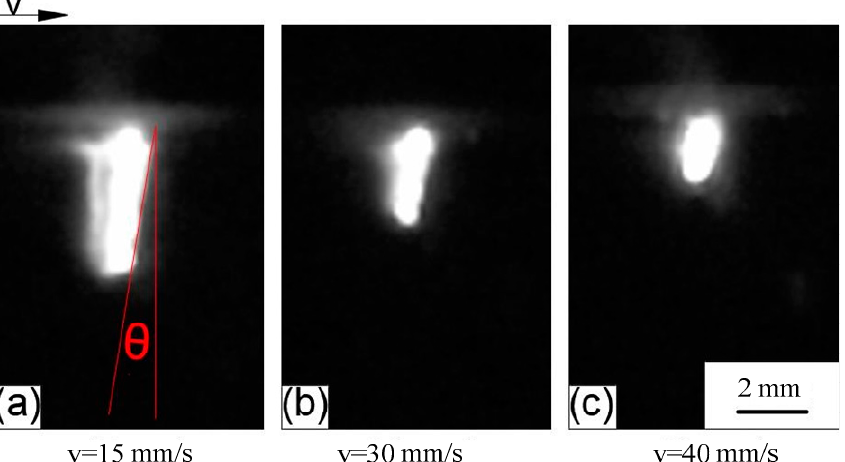
Figure 13. Keyhole shape at different speeds observed by the sandwich method: ( a ) Keyhole shape at welding speed of 15 mm/s; ( b ) Keyhole shape at welding speed of 30 mm/s; ( c ) Keyhole shape at welding speed of 40 mm/s.